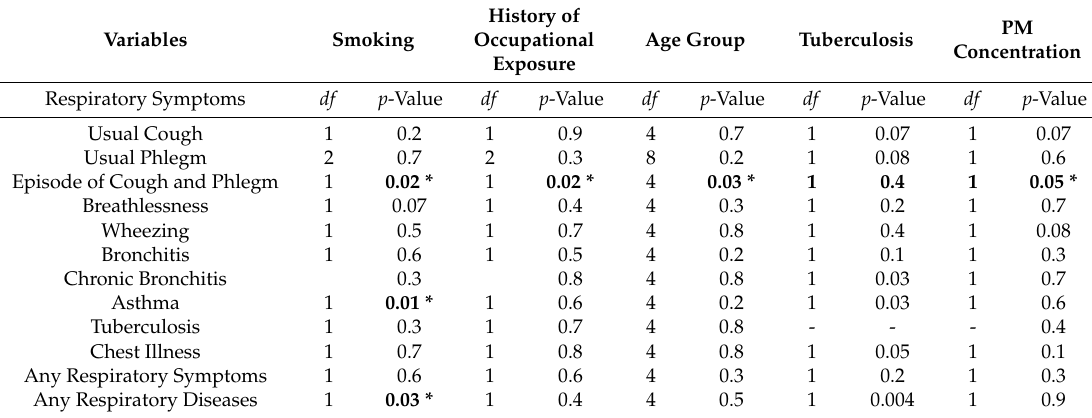
Table 6. Chi-square test of association between respiratory disorders, PM concentration, and confounding variables.